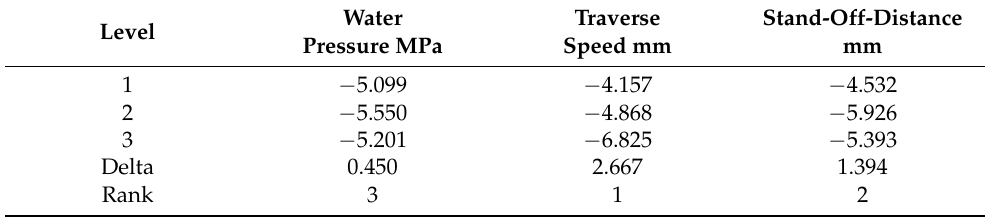
Table 24. ANOVA table for kerf taper angle response of input cutting parameters of 6 mm thickness of SPF-UPE composite cut with abrasive water jet technique.